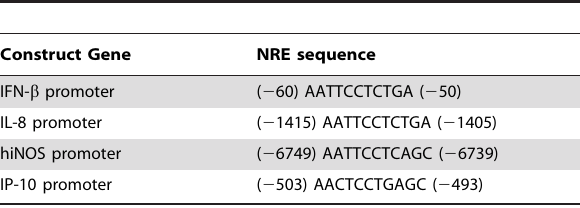
Table 2. Sequence comparison of the NRE sites in IFN- b , IL-8/ CXCL8, hiNOS, IP-10/CXCL10 promoters.